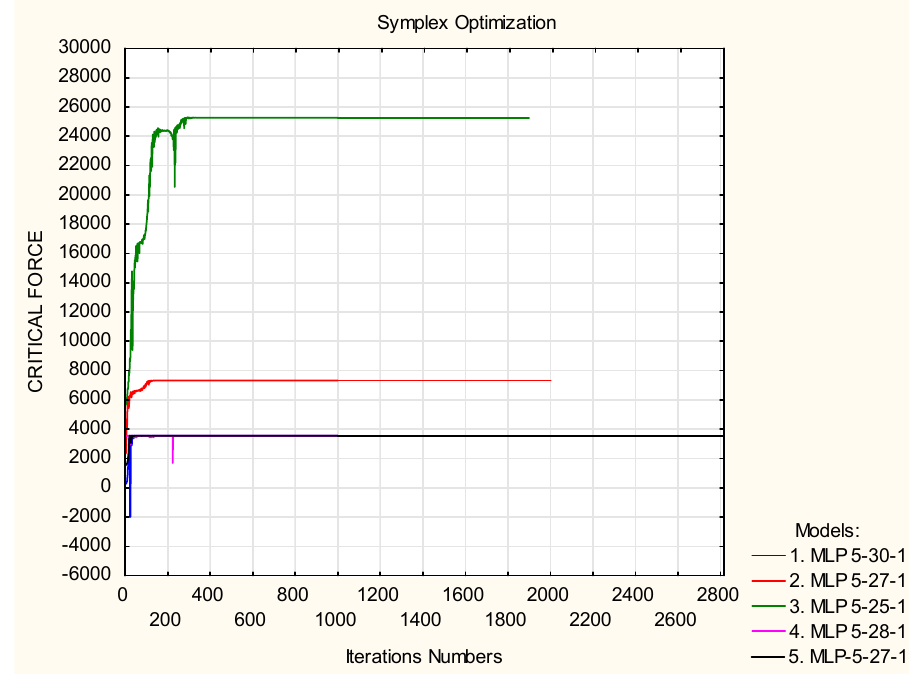
Figure 16. Values of the critical forces [N] in iterations. Table 6. The values of the optimum angle configurations determined for each neural network as well as the values of the predicted critical forces and obtained using FEM.